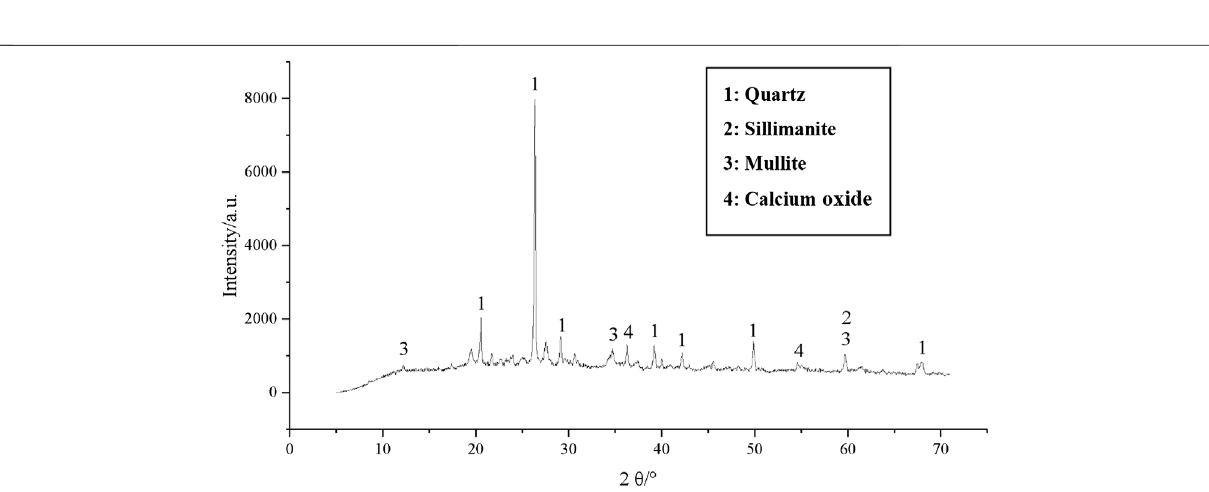
Frontiers in Materials |